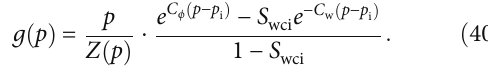
Figure 5: p / ð μ Z Þ and μ Z vs. pressure ( p ) for case studies.